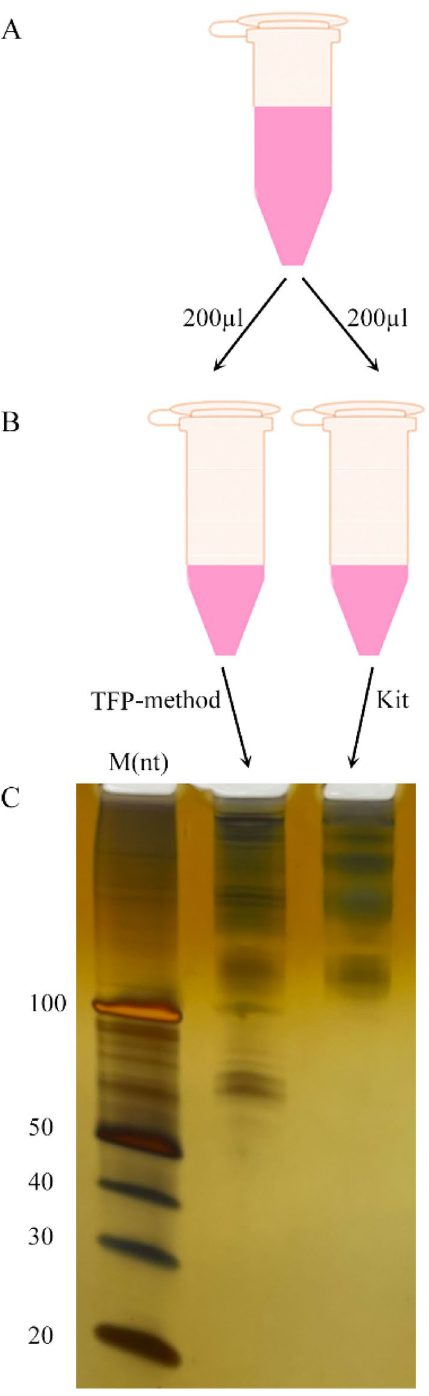
Figure 2. The extracted sncRNA distribution in the high-resolution gel was determined by silver staining. ( A ) The plasma from the same patient was mixed thoroughly before separation. ( B ) sncRNAs from 200 µl plasma were extracted by the TFP method and the kit separately. ( C ) The distribution of the yields extracted by the two methods. The full-length gel in ( C ) is presented in Supplementary Fig. S6, and the ( C ) was cropped from Lanes 1, 2, and 3 from the same